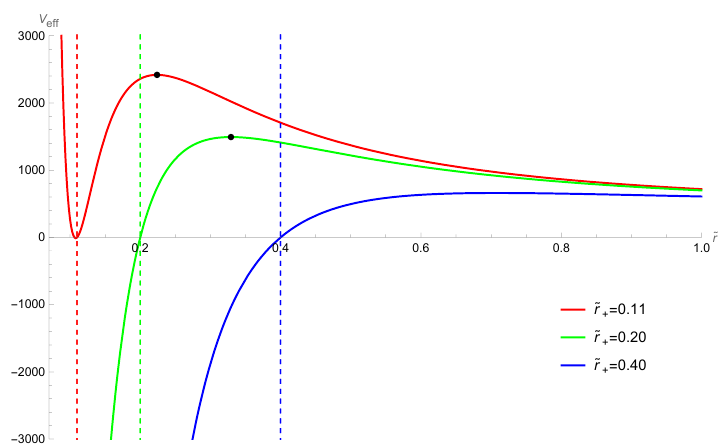
Figure 5 . Effective potential of massive particles with the angular momentum L = 20 l in the RN-AdS black holes with ˜ Q = 0 . 11 for ˜ r + = 0 . 11 , 0 . 20 and 0 . 40 . The vertical dashed lines denote the radius of the event horizon. The black dots represent the maxima of the effective potentials, corresponding to unstable time-like circular geodesics. When ˜ r + = 0 . 40 , the effective potential has no maximum.